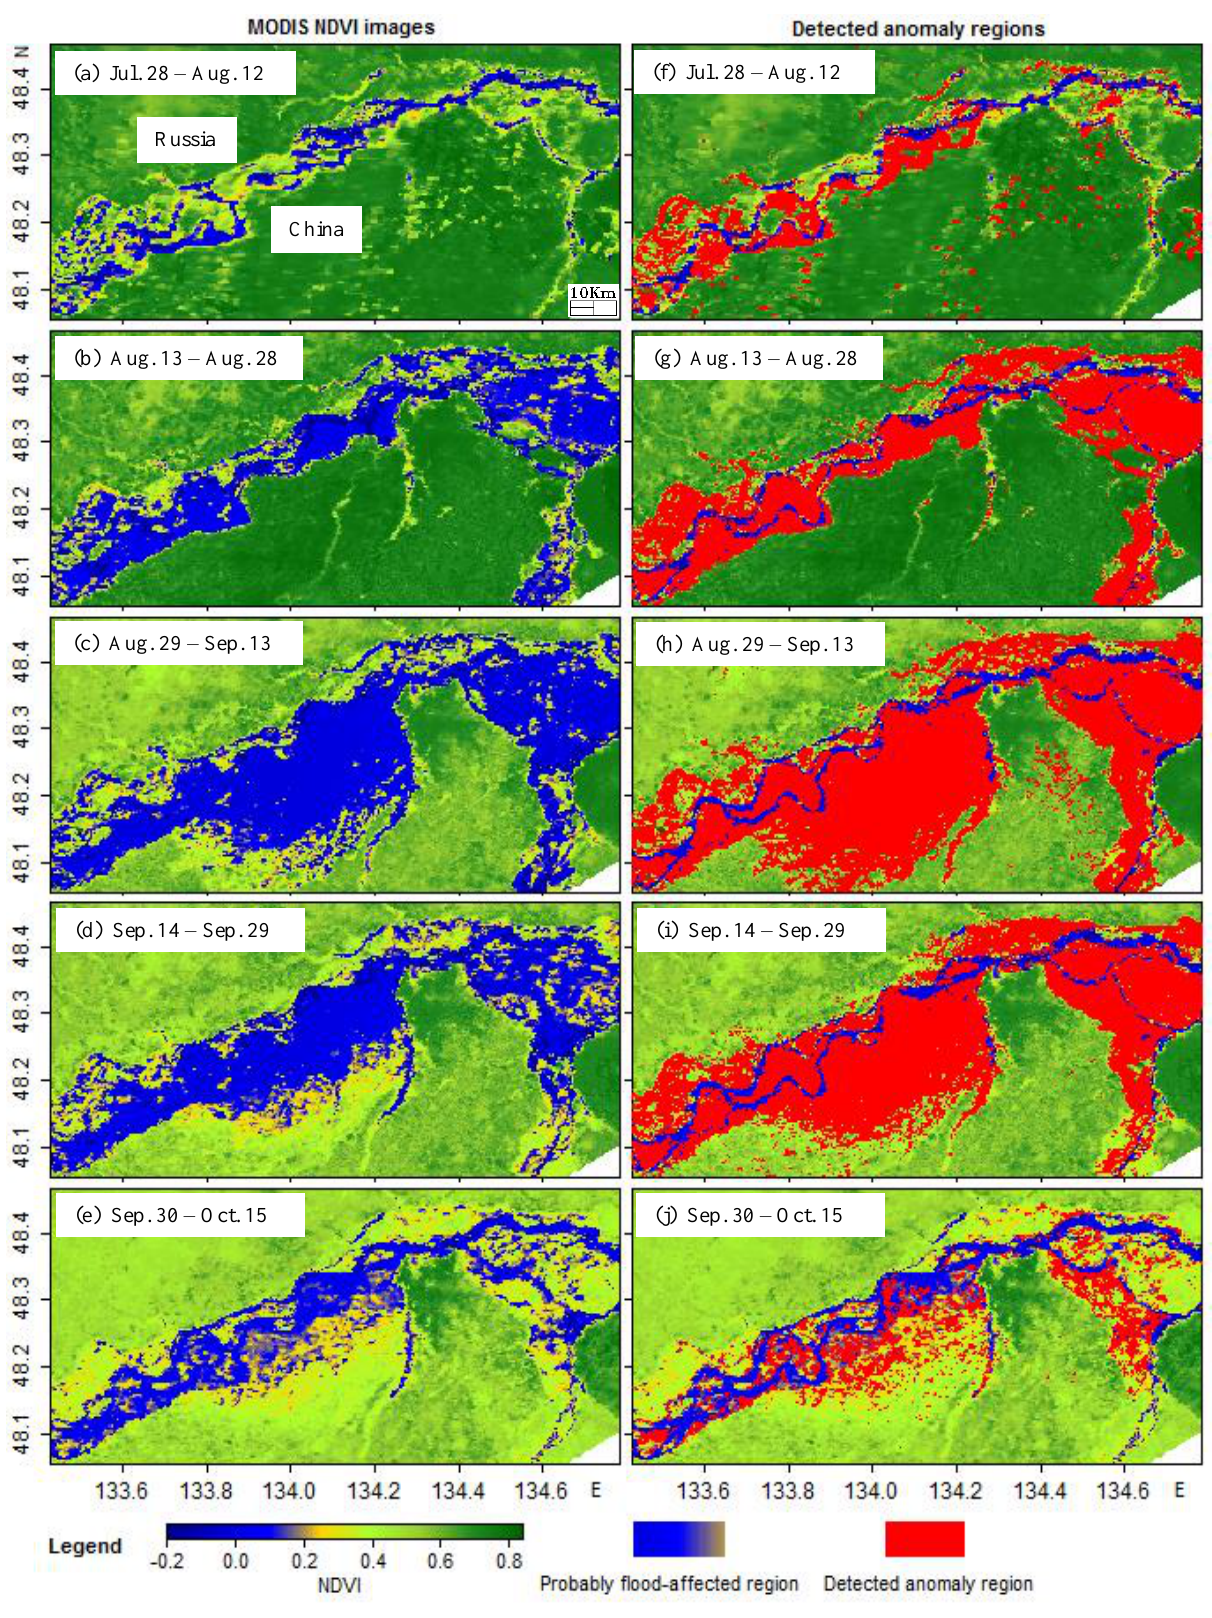
Figure 2. The MODIS NDVI image time series (left column, a-e) showing the dynamic changes of the probably flood-affected regions in 2013, and the corresponding detected anomaly regions (right column, f-j) when setting the z-value to be two. The subtitle of each image indicates the 16-day composite period of the corresponding MODIS NDVI